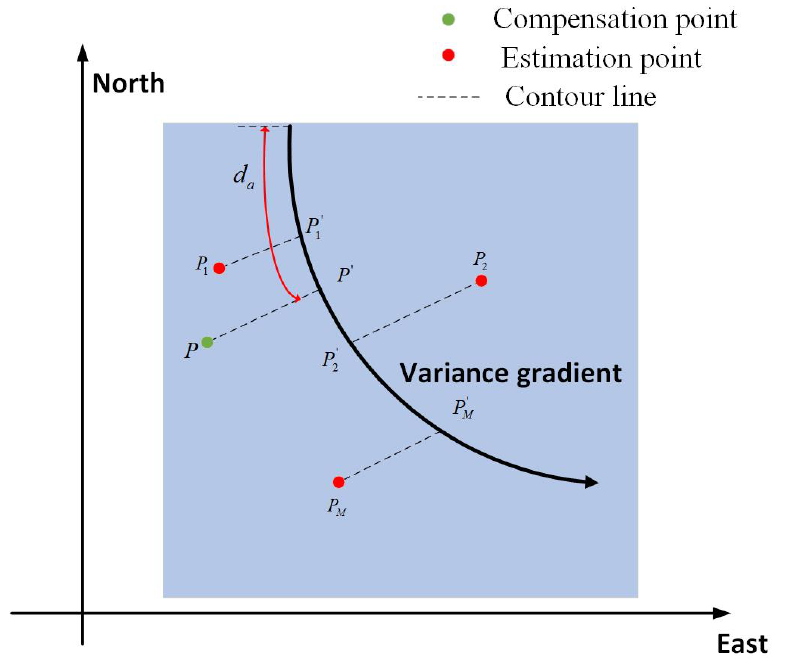
Figure 6. Nonlinear spatial variance gradient projection model in a UAV-based BiSAR